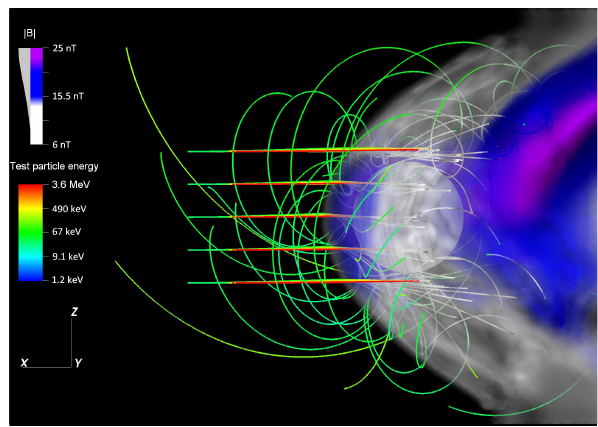
Fig. 6. Illustration of the motion of energetic protons near Mars. The “cloud” shows the strength of the magnetic field in 3-D (see the colour bar, top left). The circular white sphere represents the surface of Mars. The lines show trajectories of several energetic pro- tons. The colour of a line represents the initial energy of an ion: The lowest energies ( ∼ 30keV and 50keV) are shown in green; the yel- low trajectories represent ∼ 200keV and 600keV protons and the red trajectories ∼ 3.2MeV protons (see the colour bar, bottom left). Note that the red and yellow trajectories are almost straight lines and that they end when the ions hit the side wall of the simulation box. Note also that the colour of the initially green trajectories be- comes grey or white when the trajectory is within or behind the strong magnetic field